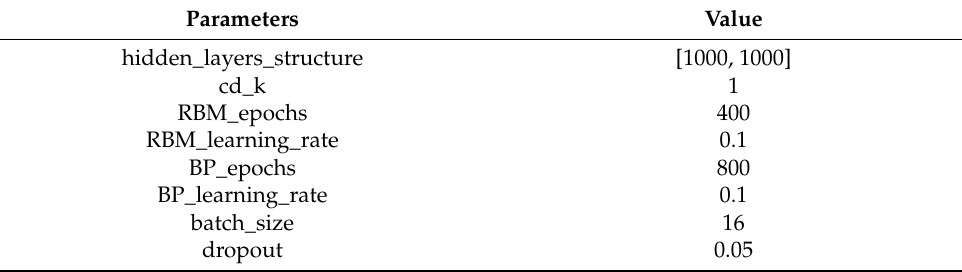
Table 4. Training parameters of the SMD-DBN